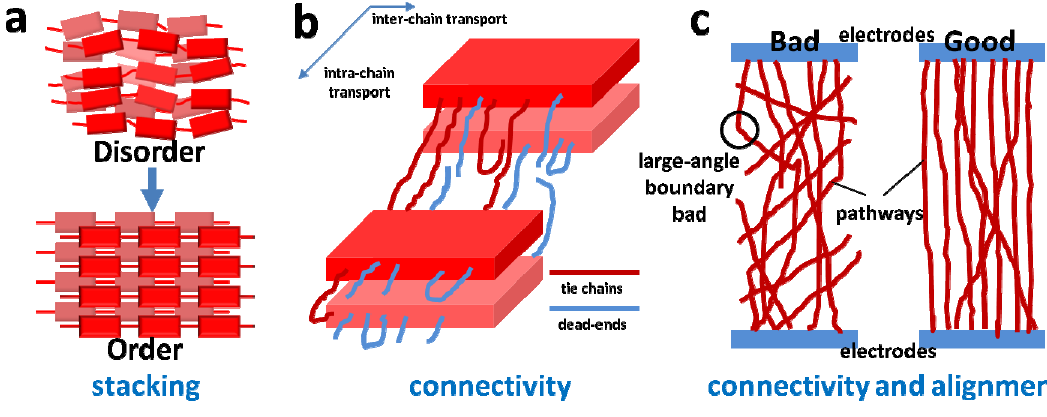
Figure 1. Scheme of the bottom-up construction of charge transport pathways with the morphological features influencing the final morphology and performances in conjugated polymer films: ( a ) the molecular stacking order; ( b ) the connectivity between adjacent crystalline regions and ( c ) the grain boundary angle and alignment of charge transport